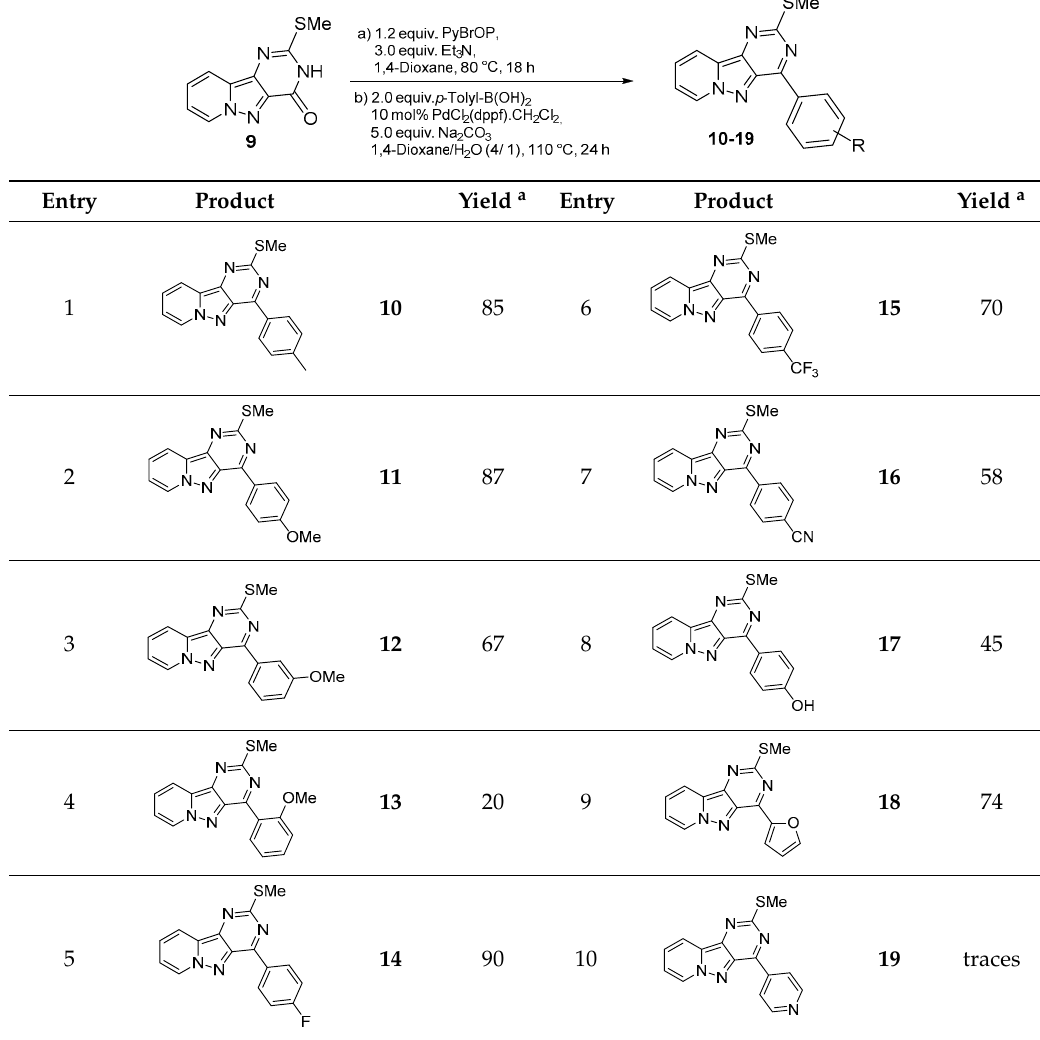
Table 1. Scope of (het)arylation of 9 under C-O amide activation.